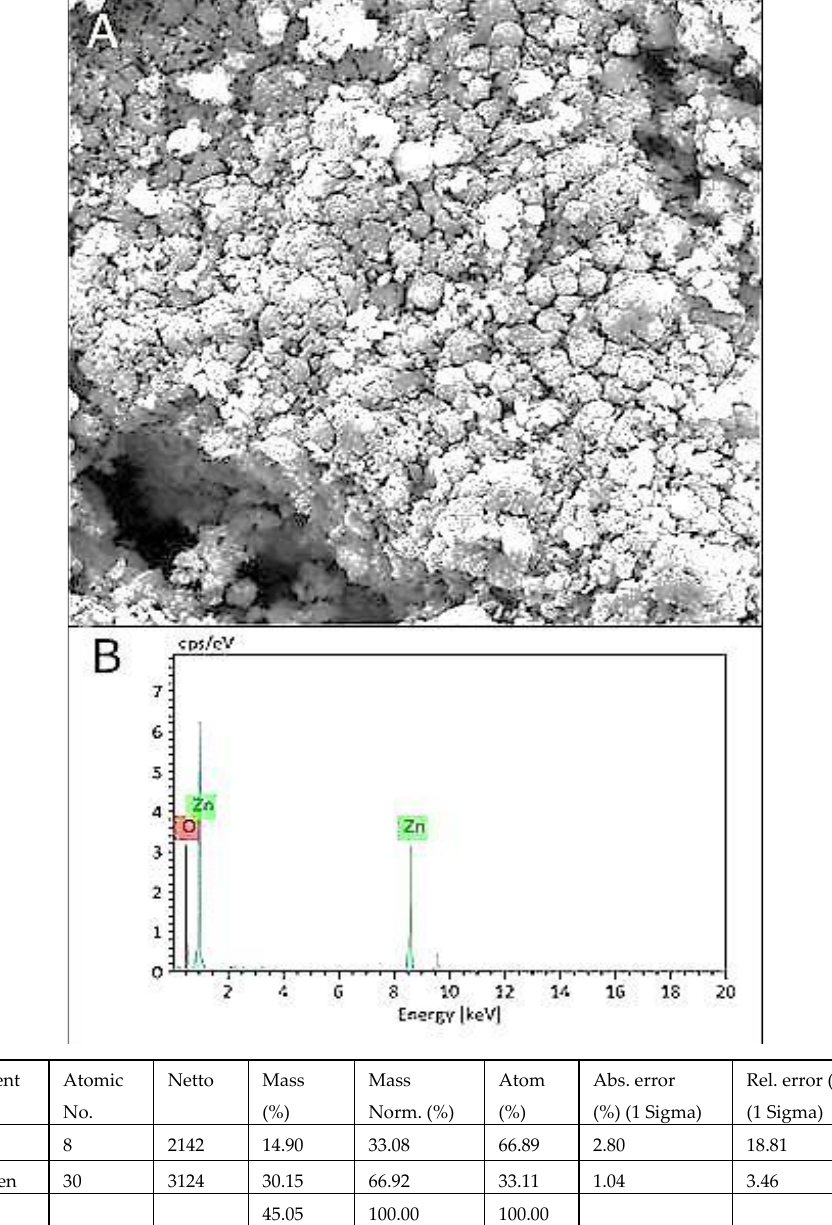
Figure 6. SEM image of ZnO NPs ( A ), EDX spectrum of ZnO NPs ( B ).